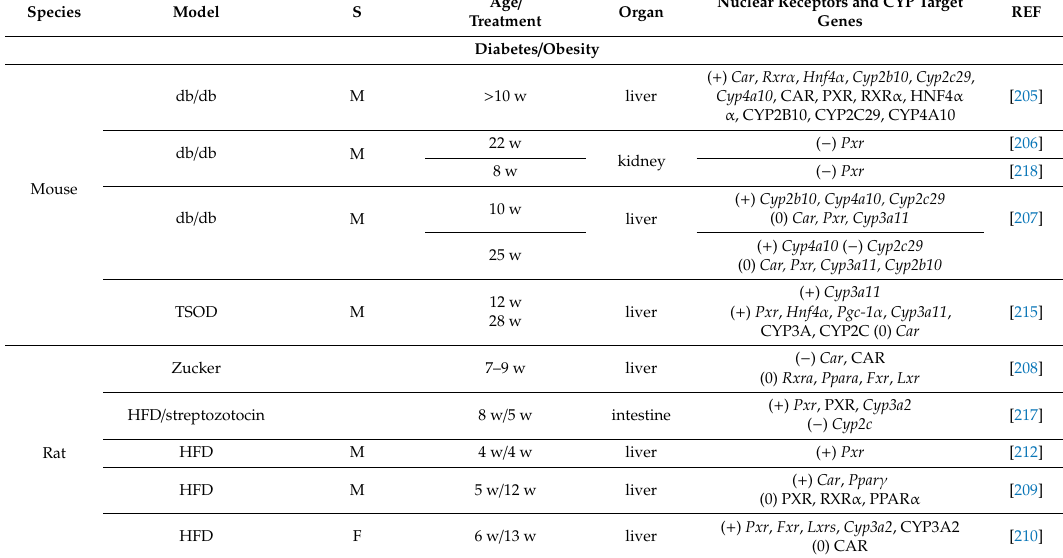
Table 3. E ff ect of di ff erent pathologies on the expression of nuclear receptors and cytochrome P450 enzyme (CYP) target